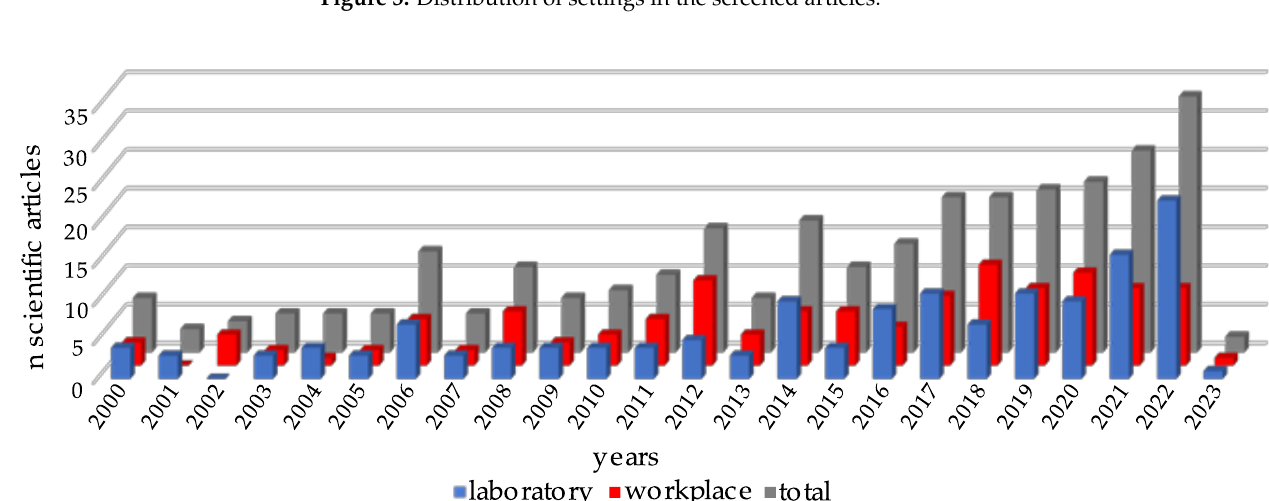
Figure 3. Distribution of settings in the screened articles.